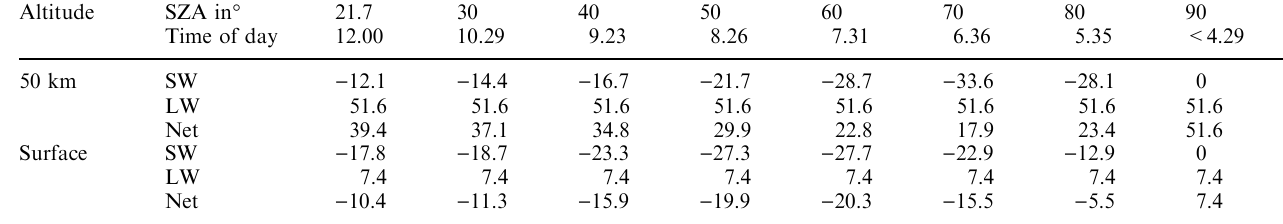
Table 5. Variation of the shortwave (SW), longwave (LW) and net radiative flux change in Wm ) 2 as a function of solar zenith angle (SZA) and morning hours, results of model M for spherical